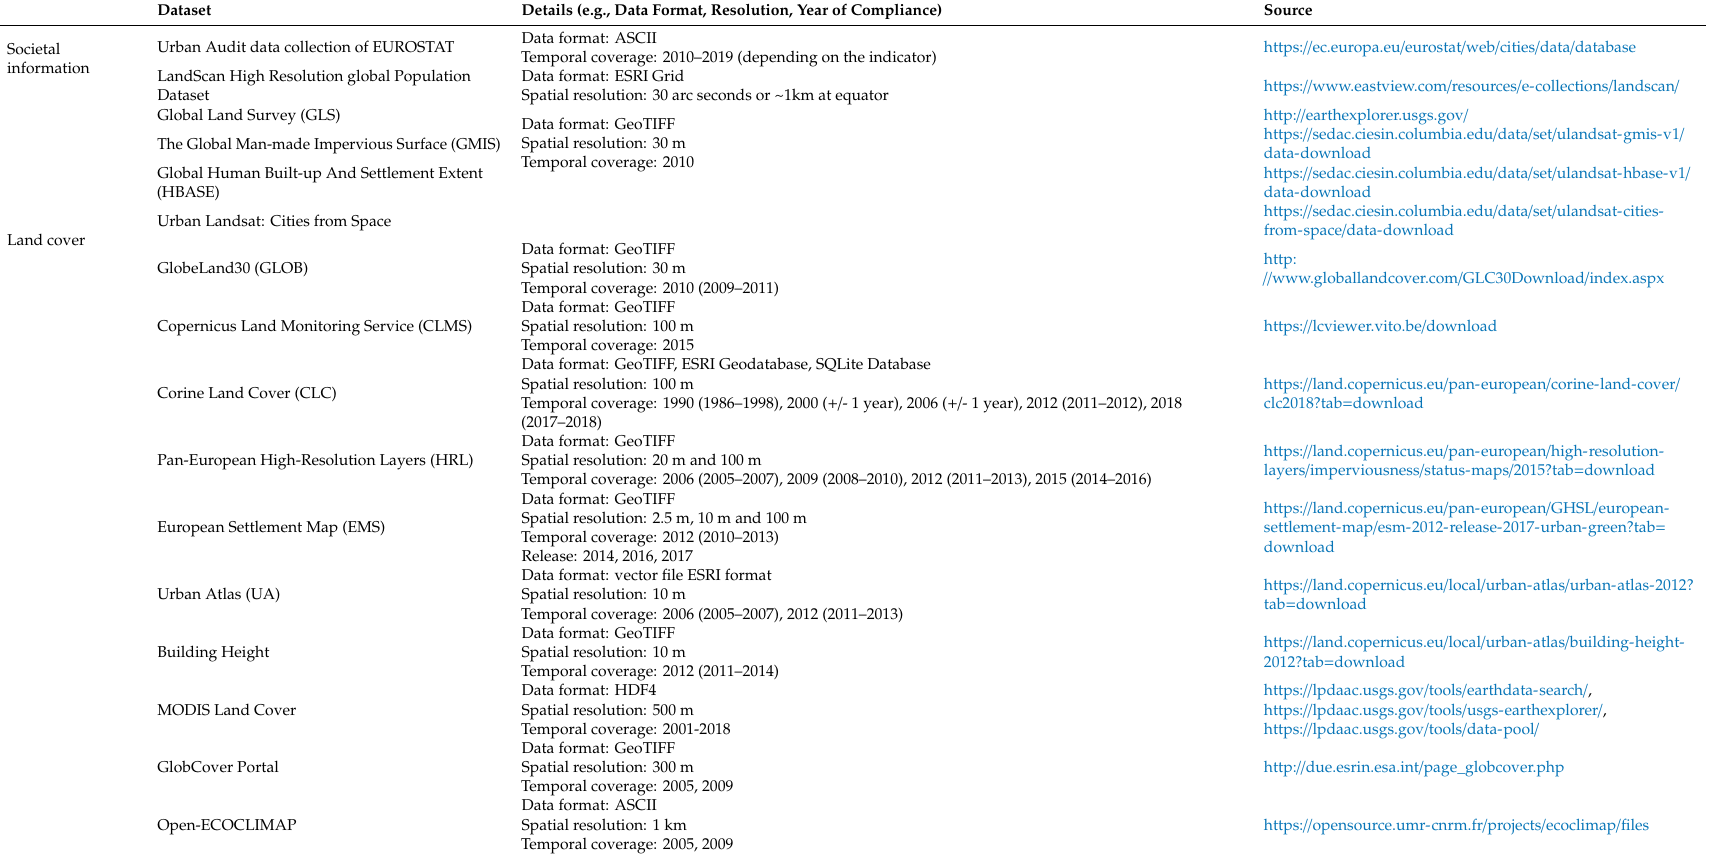
Table 3. Ancillary data sources for urban climate studies and